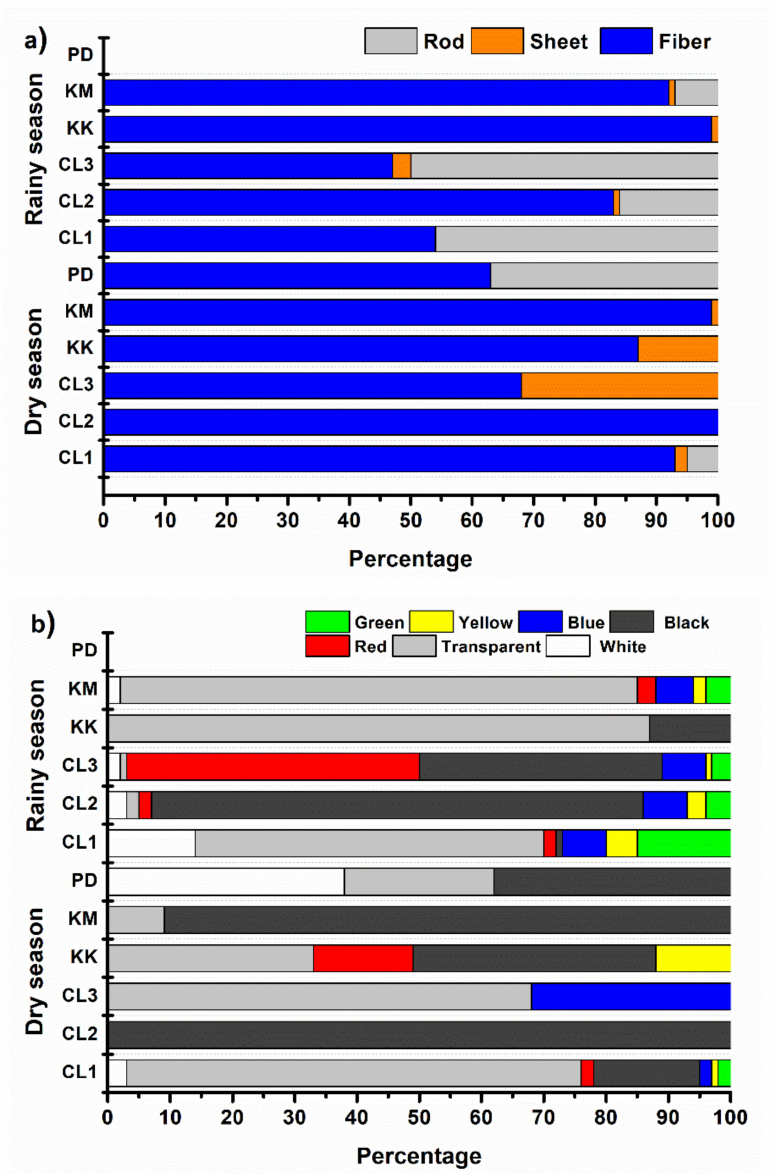
Figure 4. Percent of microplastic occurrence based on ( a ) shape, ( b )